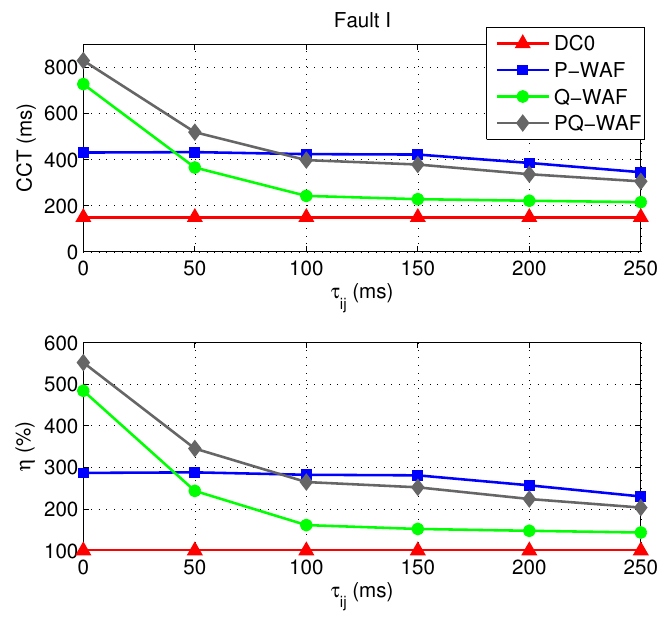
Figure 18. CCTs and η versus communication